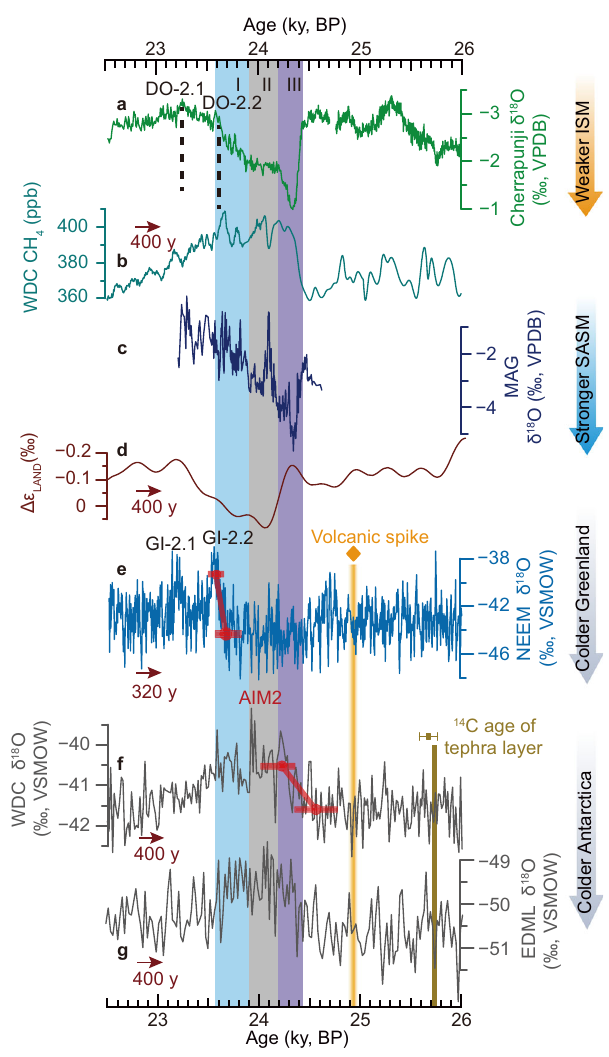
Fig.4|ComparisonbetweenAsiansummermonsoon/SouthAmericansummer monsoon and ice-core records. a Cherrapunji δ 18 O record (this study) from Cherrapunji Cave in the ISM domain, b Antarctica WDC ice-core CH 4 record 24 , c MAG δ 18 O record(thisstudy) from Marota Cave inthe SASMdomain, d Antarctic ice-core composite Δε LAND proxy 71 , e Greenland NEEM ice-core δ 18 O record (Sup- plementary Note 1.5) on the improved chronology (GICC05 timescale +320 years) (see main text), f , g are Antarctic ice-core δ 18 O records from WDC 13 and EDML 95 , respectively. Antarctic ice-core records are plotted on the WD2014 chronology 63 , which is shifted by +400 years via a correlation based on the volcanic triplet spike (depicted by the orange diamond and the vertical bar at ~24.94 ky BP). It is noted thattheEDML δ 18 OrecordhasbeentunedtotheWD2014chronologyinaprevious study 16 . Red dots and associated error bars in ( e ) and ( f ) indicate the timing and combined uncertainties (2 σ ) of the change points in Greenland and Antarctic ice- core δ 18 O records (Supplementary Table 2). The Brown error bar depicts the 14 C age 66 and uncertainty (1 σ ) of the Oruanui eruption from the Taupo volcano. The verticalbarat~25.72kyBPmarksthetephralayeroftheOruanuieruptionrecorded in the WDC ice core 64 . The two vertical dashed lines depict the DO-2.1 and DO-2.2 peaks. Cave, ice-core and volcano locations are shown in Supplementary Fig. 2. Vertical bars are the sameasin Fig. 2.AIM Antarcticisotope maximum 95 , ppbparts per billion, ISM Indian summer monsoon, SASM South American summer